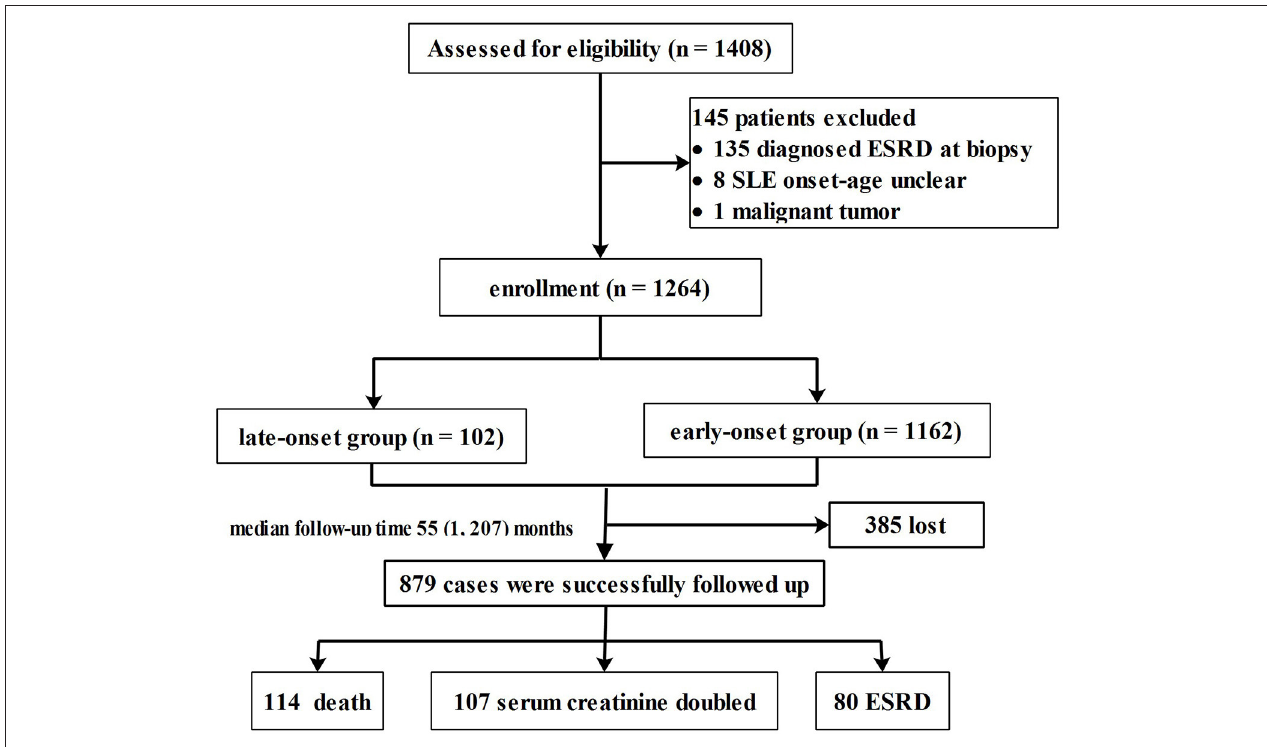
FIGURE 1 | Enrollment and follow-up of study